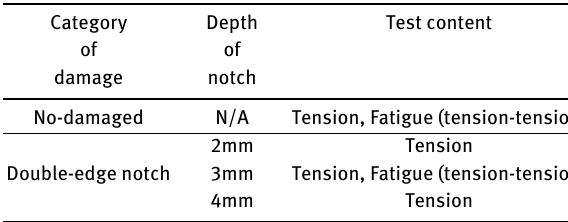
Table 2: Test matrix of 3238A/CF8652